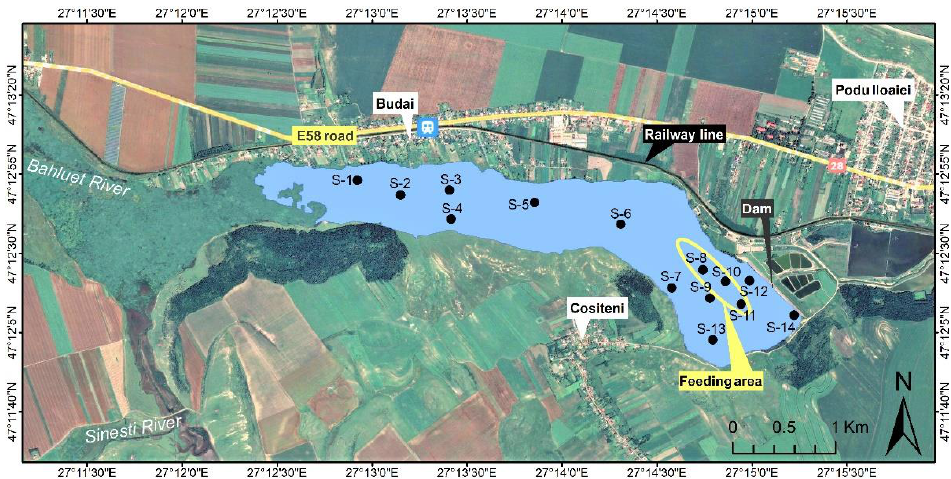
Figure 1. Map of the Podu Iloaiei Dam Lake and the distribution of sediment sampling sites (the Image © 2022 CNES/Airbus from Google Earth Pro was incorporated in the present figure).